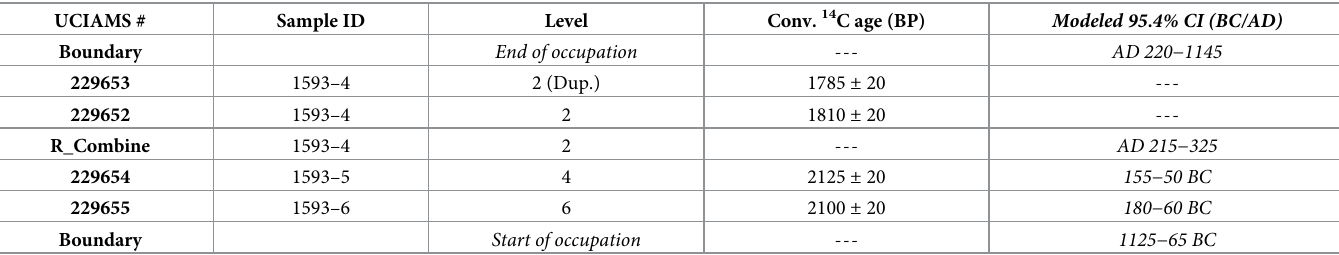
Table 3. Radiocarbon dates for unit NE1K, including modeled sequence, 95% probability ranges, and